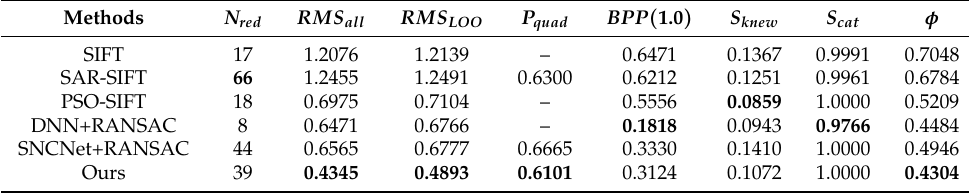
Table 1. The quantitative comparison among six methods on Wuhan images.